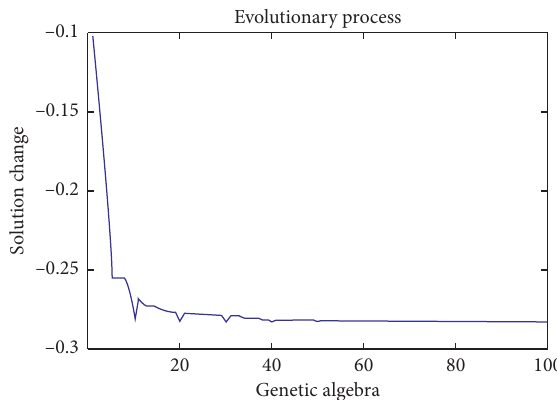
Figure 8: Iteration diagram of genetic algorithm.